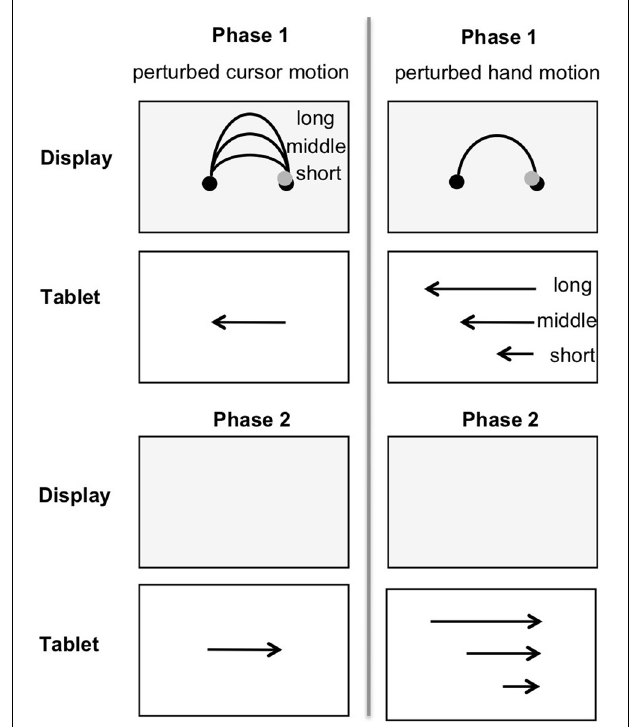
FIGURE 3 | Perturbed cursor motion (upper part, left). In phase 1 cursor paths were short (60mm), middle (120mm), or long (180mm), while hand amplitude and visual target distance were constant (each 50mm). Perturbed hand motion (upper part, right). In phase 1 hand amplitudes were short (25mm), middle (50mm), or long (75mm), while cursor path length and visual target distance remained constant (120 and 50mm, respectively). In phase 2 (lower part) the initially performed hand amplitude was replicated without any visual feedback.